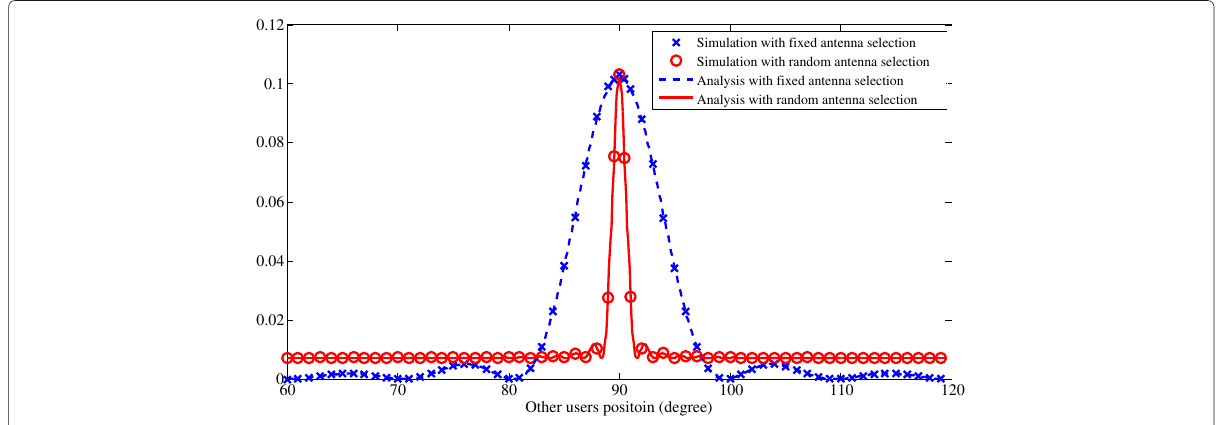
Fig. 5 The variance of total interference to a user located at 90 o : M = 12, K =